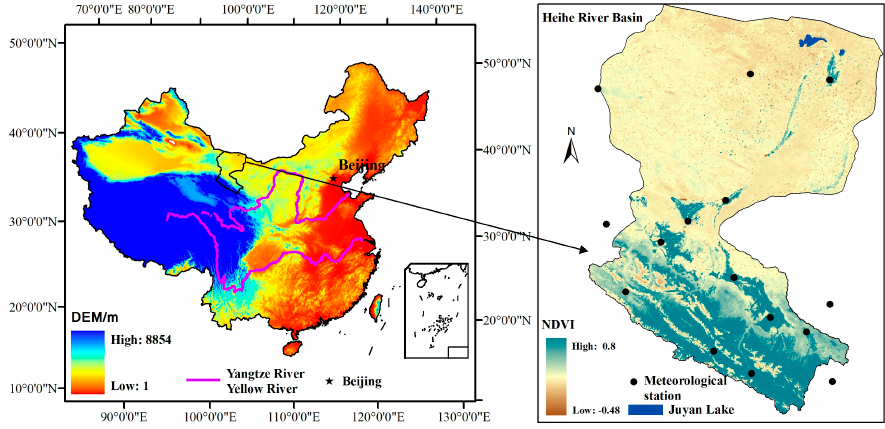
Figure 1. Location of observation sites in the Heihe River Basin.